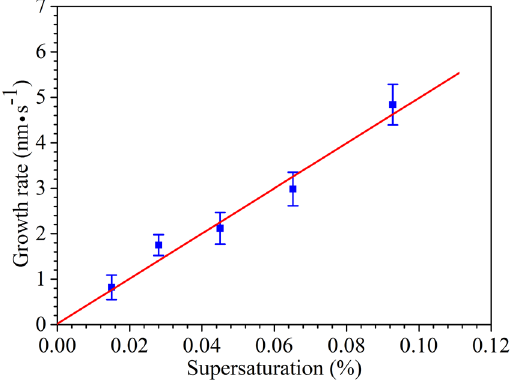
Figure 3. The fitted curve of the growth rates for α -Al 2 O 3 nanowires as a function of